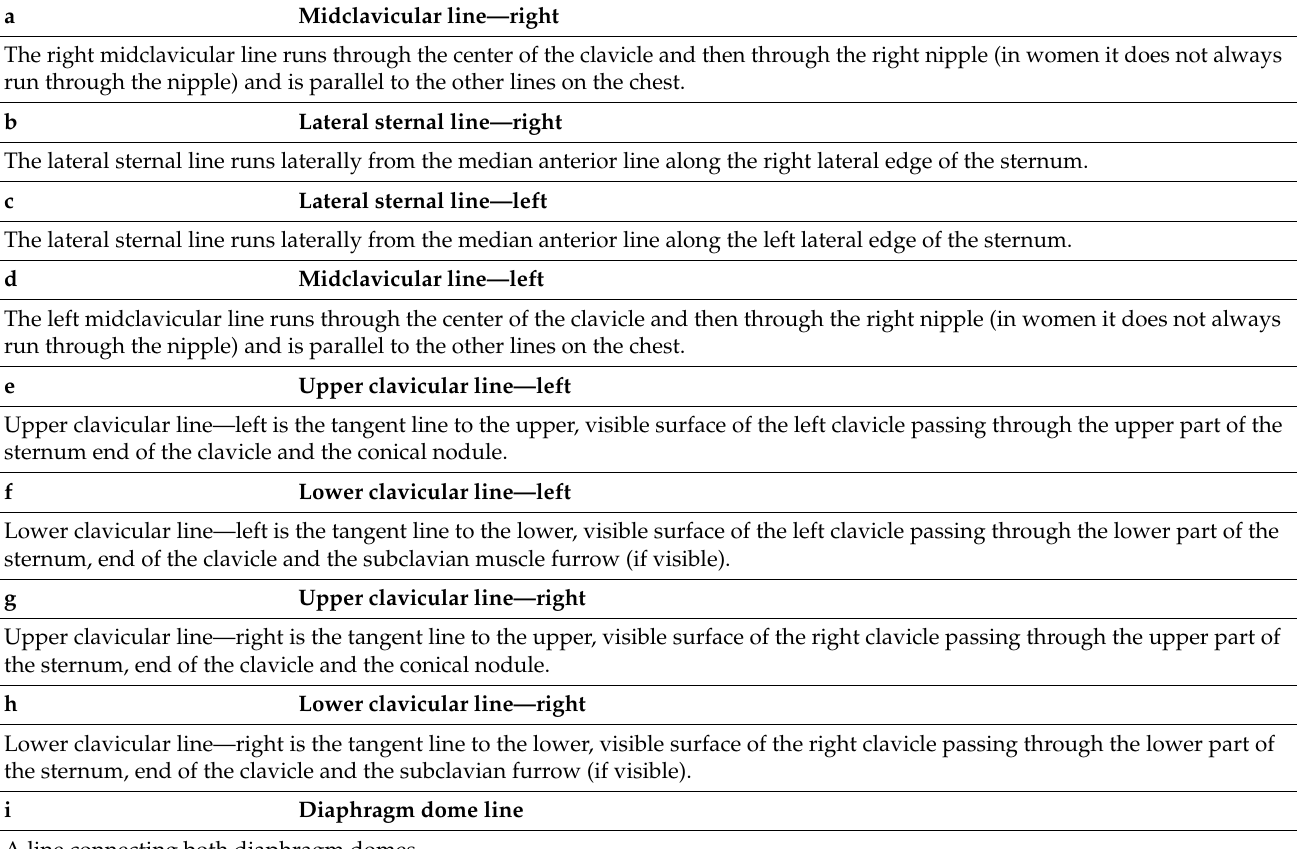
Table 1. Definitions of the anatomical lines used to make